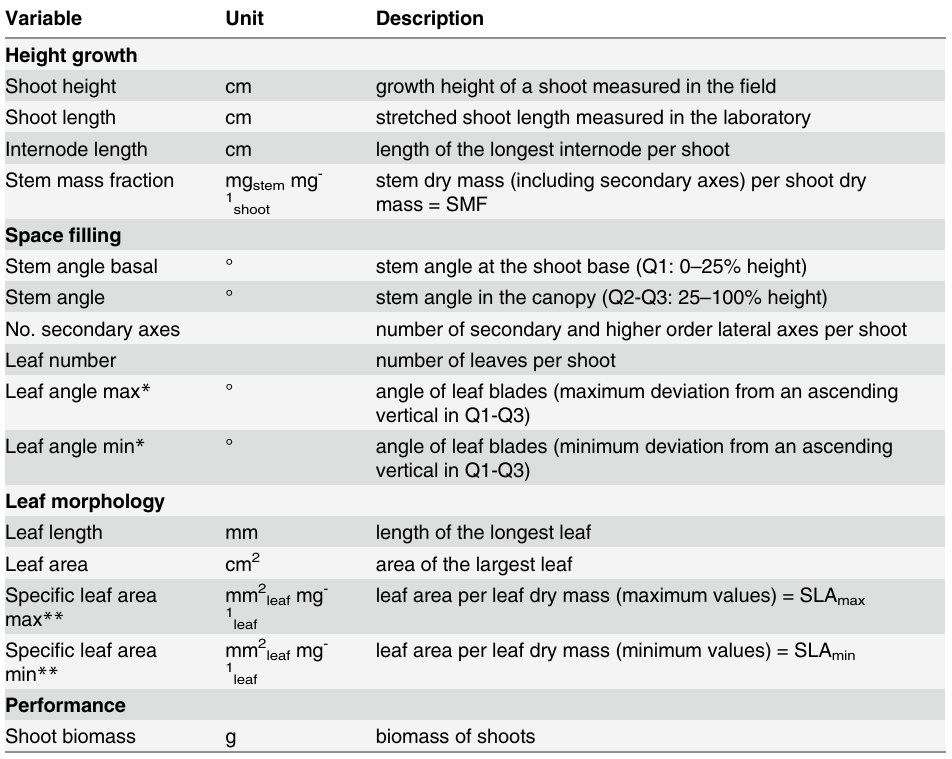
Table 1. Overview of traits related to light acquisition analysed in this